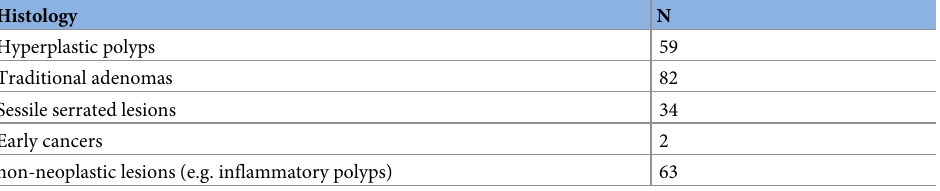
Table 2. Clinicopathological features of polyps of the validation